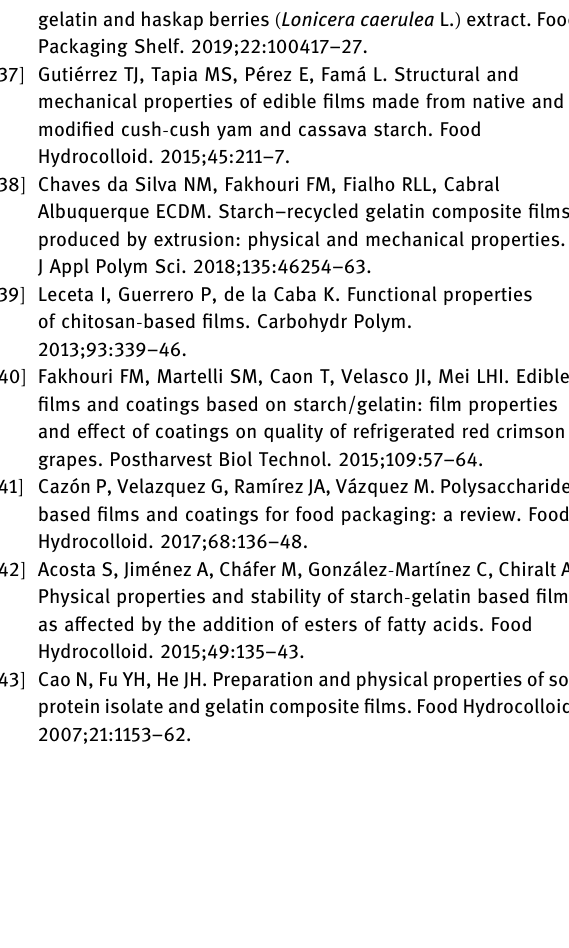
tableware based on soybean dregs by response surface method ( in Chinese ) . Process Agric prod. 2019;475:1 – 5. [ 31 ] Nazmi NN, Isa MIN, Sarbon NM. Preparation and characteri